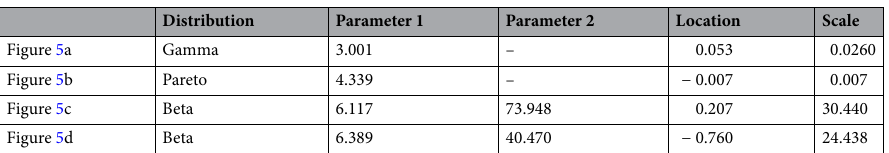
Table 3. Fitted parameters for the distributions seen in Fig. 5 . All fits were done using Scipy 57 and, consequently, the values reported here follow Scipy ’s